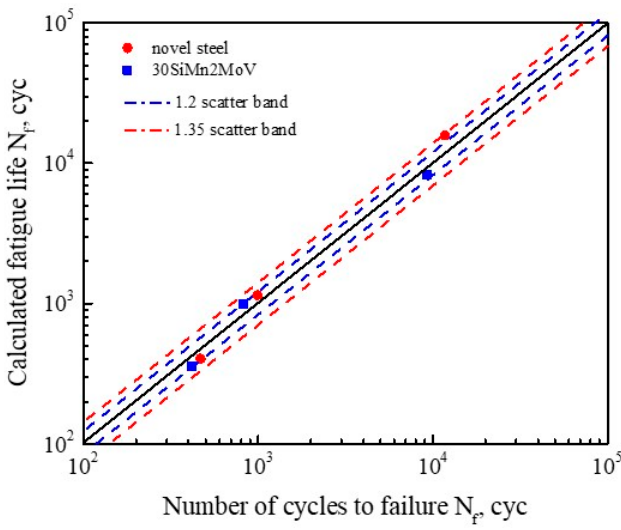
Figure 11. The comparison of calculated values of fatigue life with experimental life.